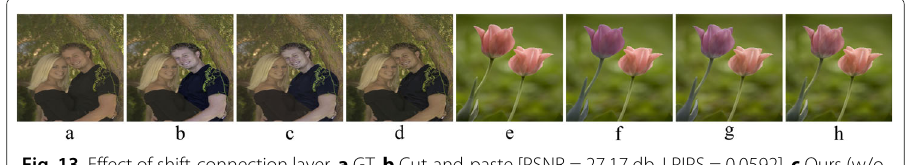
Fig. 13 Effect of shift-connection layer. a GT. b Cut-and-paste [PSNR = 27.17 db, LPIPS = 0.0592]. c Ours (w/o Shift) [PSNR = 29.59 db, LPIPS = 0.0548]. d Ours [PSNR = 33.82 db, LPIPS = 0.03167]. e GT. f Cut-and-paste [PSNR = 28.40 db, LPIPS = 0.0422]. g Ours (w/o Shift) [PSNR = 29.90 db, LPIPS = 0.0402]. h Ours [PSNR = 32.71 db, LPIPS = 0.0257]